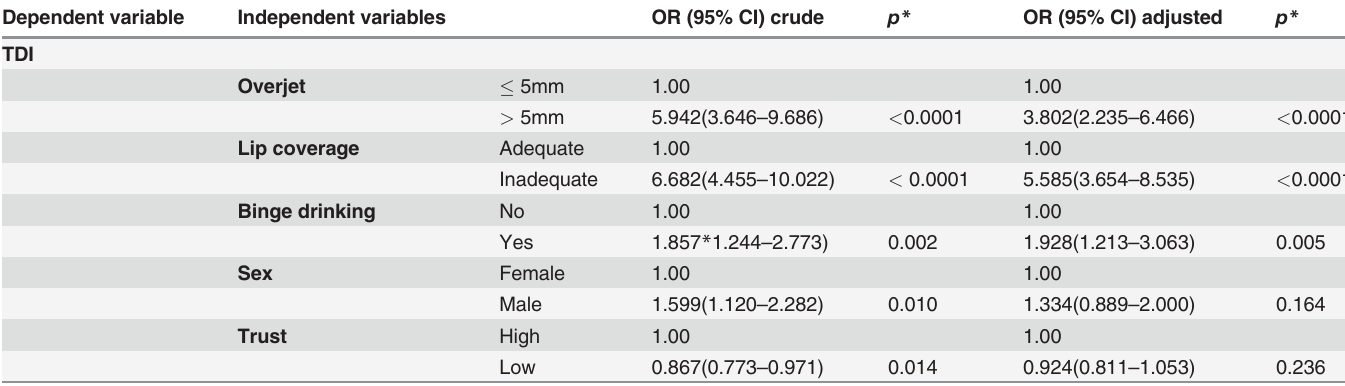
Table 3. Multivariate logistic regression analysis of dental trauma and independent variables among 588 12-year-old schoolchildren, Brazil, 2014. Dependent